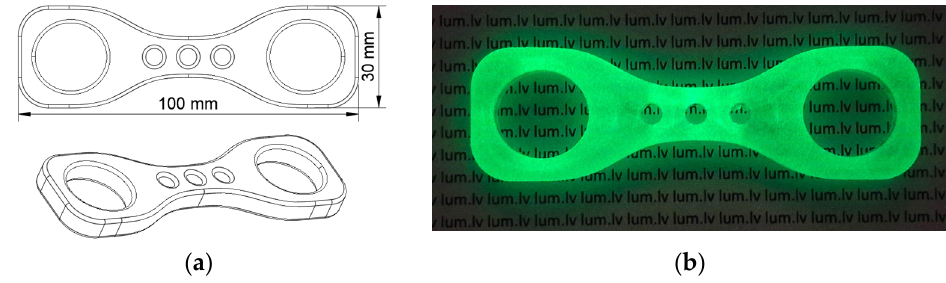
Figure 1. ( a ) Used dog-bone-like design as seen in Fusion360; ( b ) sample with 20 luminescent layers 30 s after UV